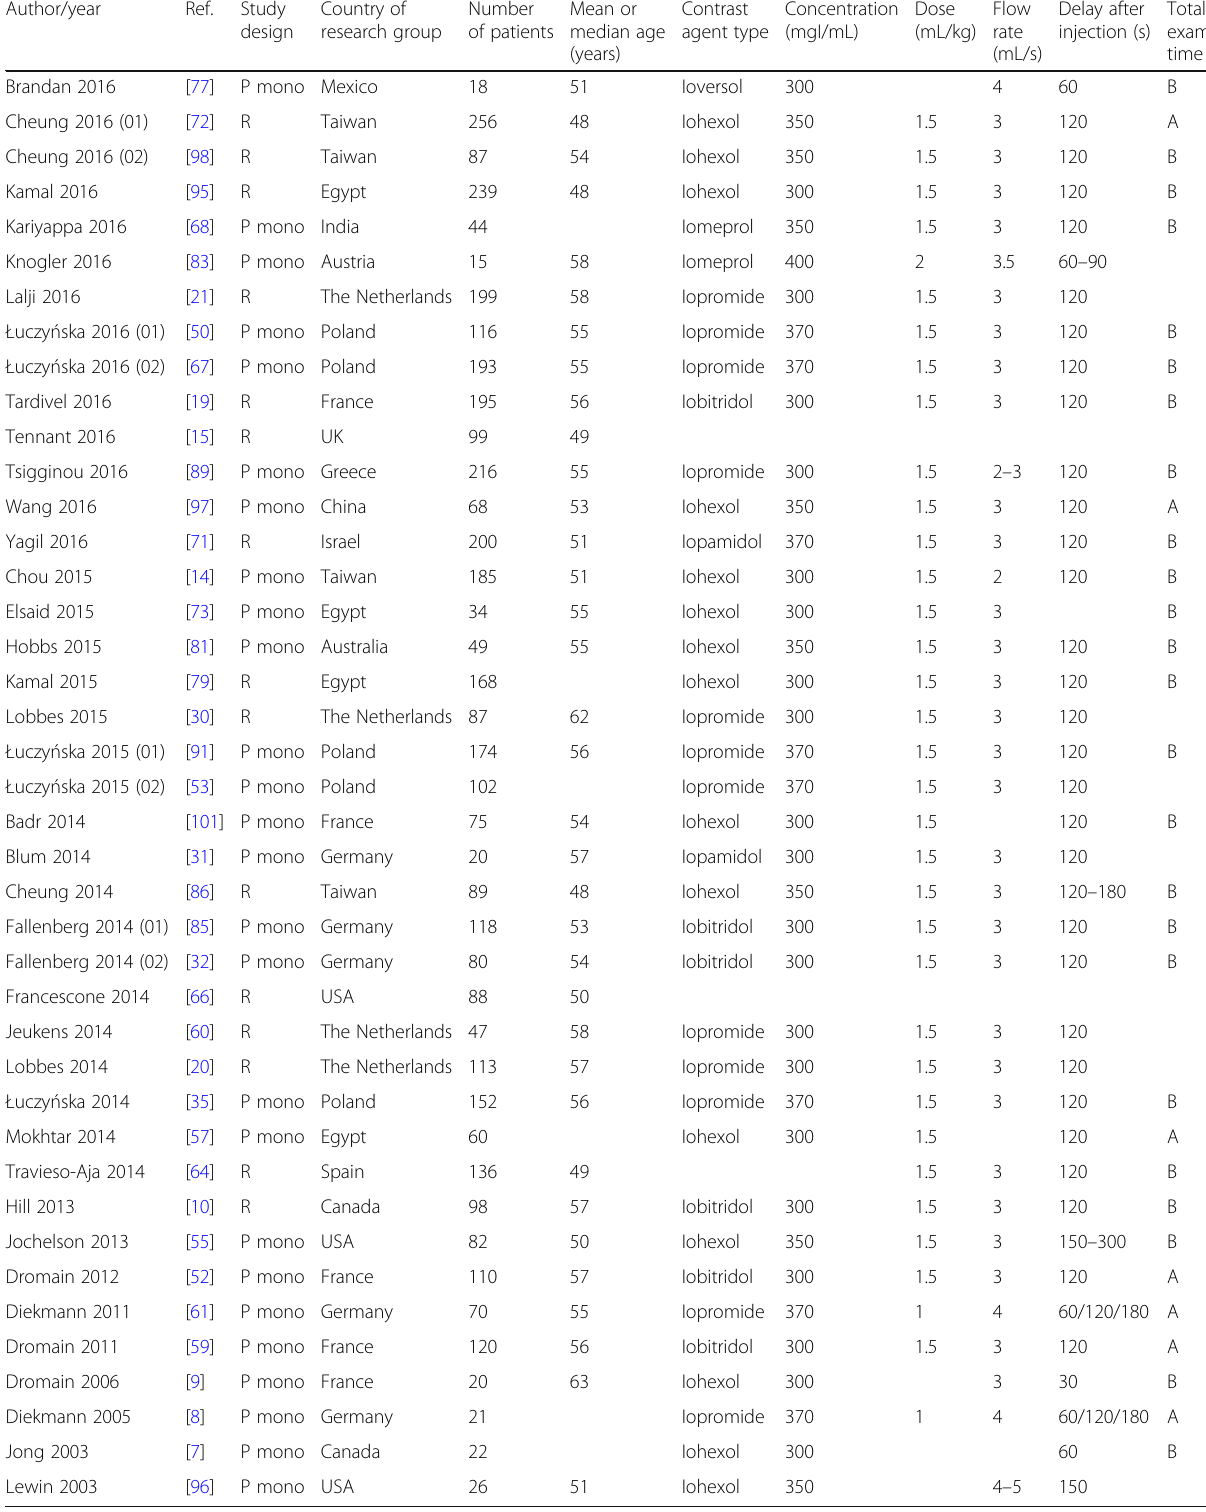
Table 1 Main characteristics of the 84 analysed studies